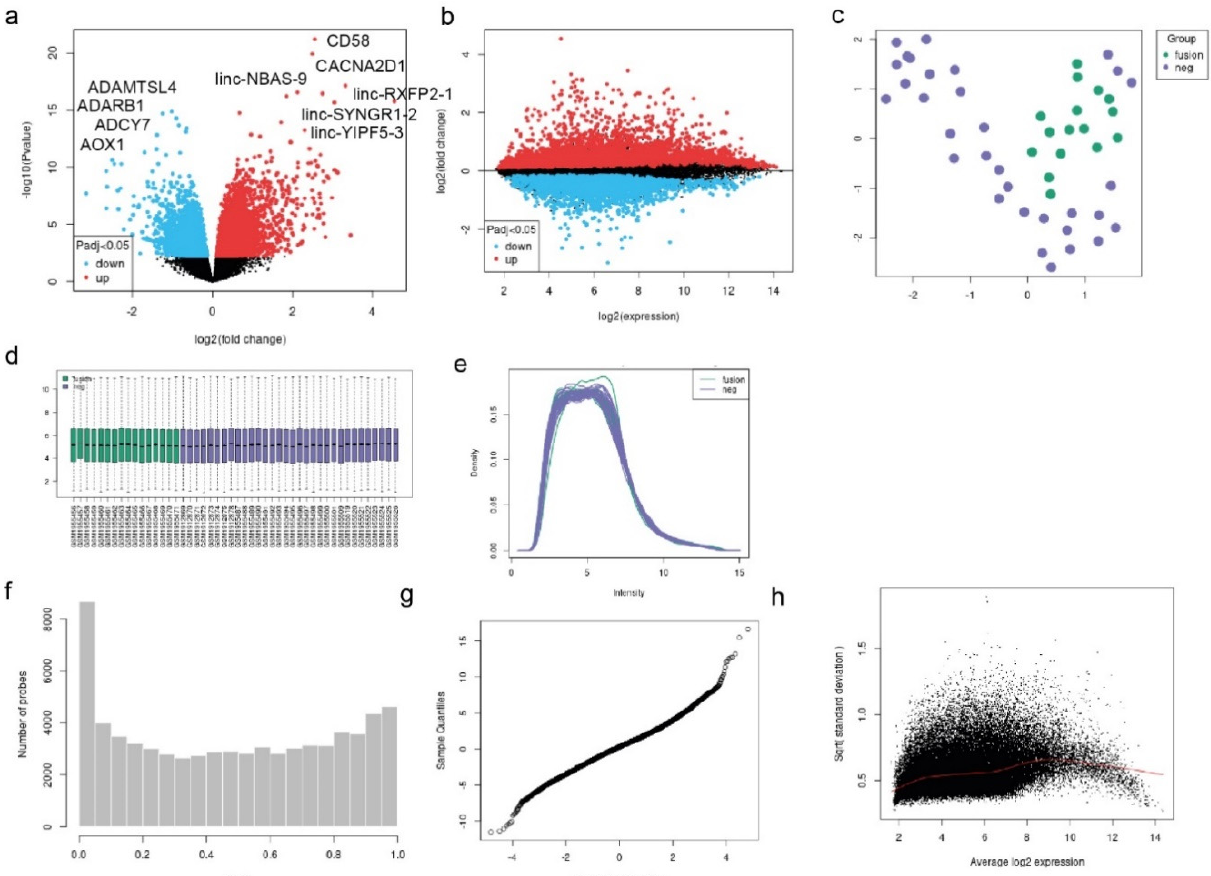
Figure 4. GSE75461 dataset analysis between RUNX1/RUNX1T1 fusion and RUNX1 AML patients. ( a ) The volcano plot depicts the statistical significance ( − log 10 p -value) against the magnitude of change (log 2 fold change) across the differentially expressed genes in pediatric RUNX1/RUNX1T1 AML patients. Highlighted genes are significantly deregulated (adj. p -value ≤ 0.05) (red = upregu- lated, blue = downregulated). ( b ) The mean difference (MD) plot displays the log 2 fold change versus average the log 2 expression of the differentially expressed genes in pediatric RUNX1/RUNX1T1 AML patients. ( c ) UMAP clustering discriminated RUNX1/RUNX1T1-positive from RUNX1/RUNX1T1-negative pediatric AML samples. ( d ) Distribution of the log transformed and normalized gene expression values and density curves ( e ) across all pediatric AML samples. The median-centered values indicate that the data are normalized and cross-comparable. ( f ) The histogram depicts the distribution of the p -values. ( g ) Moderated t-statistic quantile-quantile (q-q) plot. ( h ) Mean-variance trend plot, as explained above.